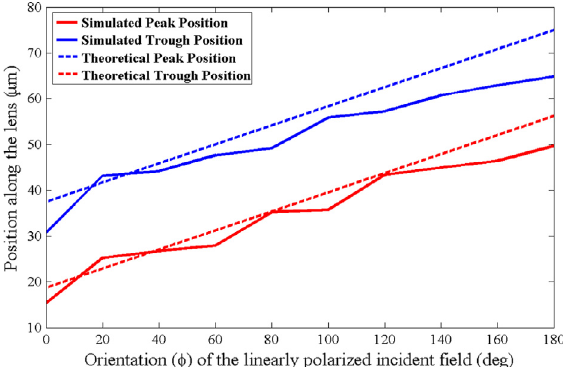
Figure 15. The theoretical result of the transmitted intensity ~ E t (cid:9) (cid:9) (cid:9) (cid:9) 2 vs. the spatial position x for various orientation angles / of a linearly polarized incident plane wave. The spatial positions of the peaks and troughs vary correspondingly with the orientation angle.